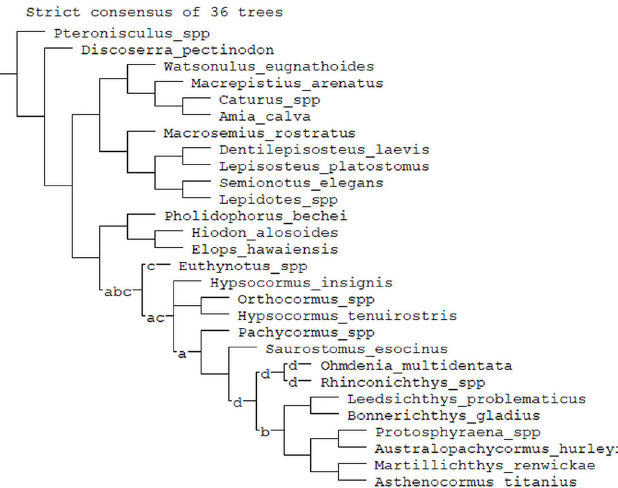
Figure 3. Reduced consensus tree generated by using the prunnelsen command in TNT, with four taxa exclud- ed (122 characters, 28 taxa) Legend of excluded taxa:- a: Hypsocormus ‘ macrodon ’, b: Pseudoasthenocormus retrodorsalis ; c: Haasichthys michelsi ; d: Sauropsis spp.